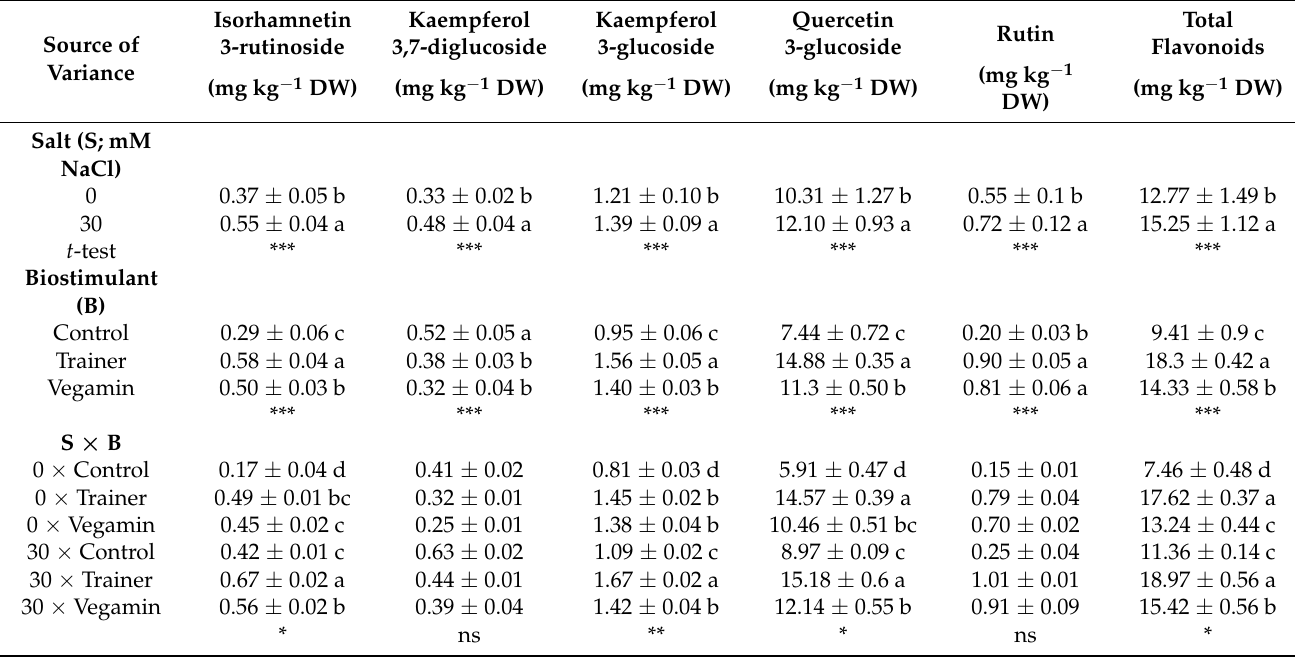
Table 6. The modulation of the leaf content of flavonoids as affected by salinity and biostimulant